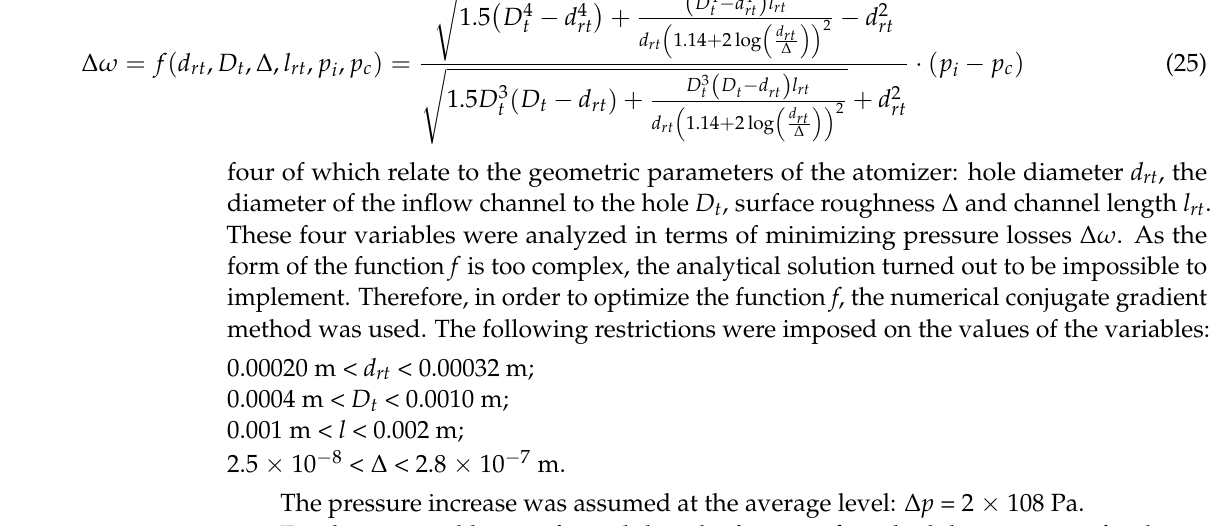
Figure 7. The course of absolute pressure loss ∆ ω , as a function of channel length l rt .